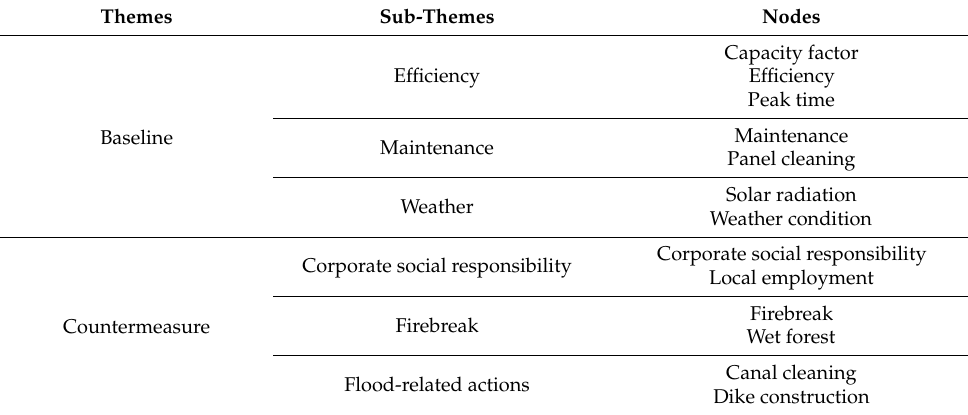
Table 5. Result of thematic